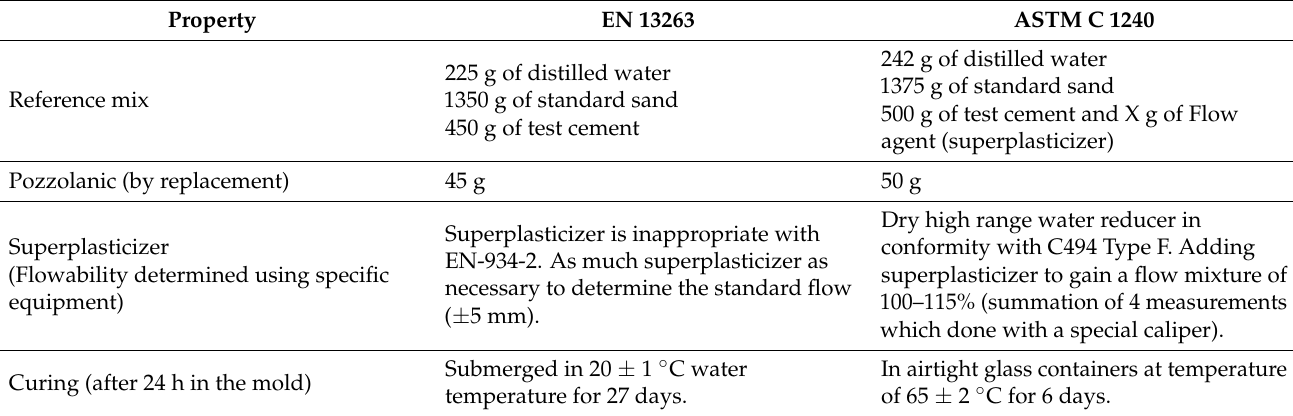
Table 7. Comparison of measurements in standards for the properties of pozzolanic